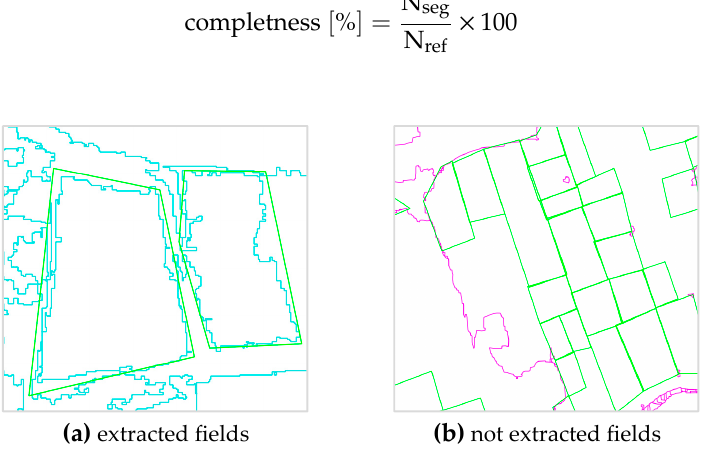
Figure 5. REF (green) overlaid with the image segmentation results from MRS (blue) and CD (pink). Image tiled subsets are representative of the general patterns of the two techniques.